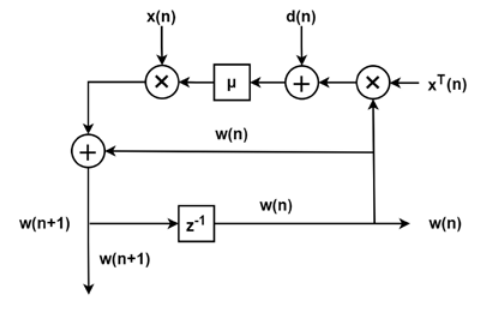
Fig. 1. Vector flow chart of LMS